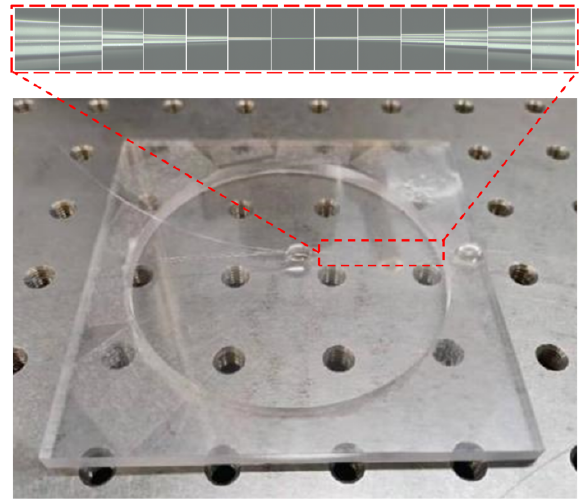
Figure 6. Photograph of the nanofiber coupler acoustic